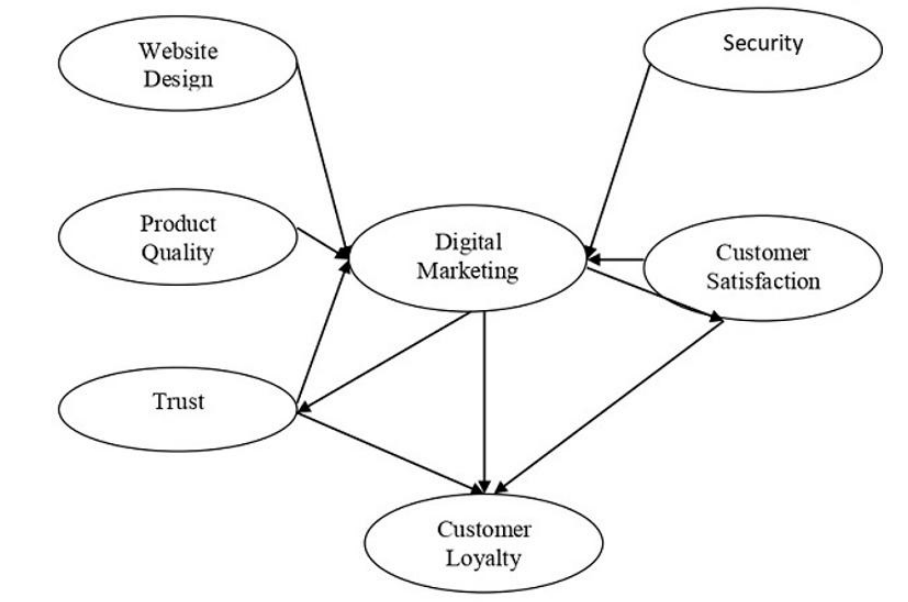
Figure 1: Conceptual Model of the Study (Source: Authors‟